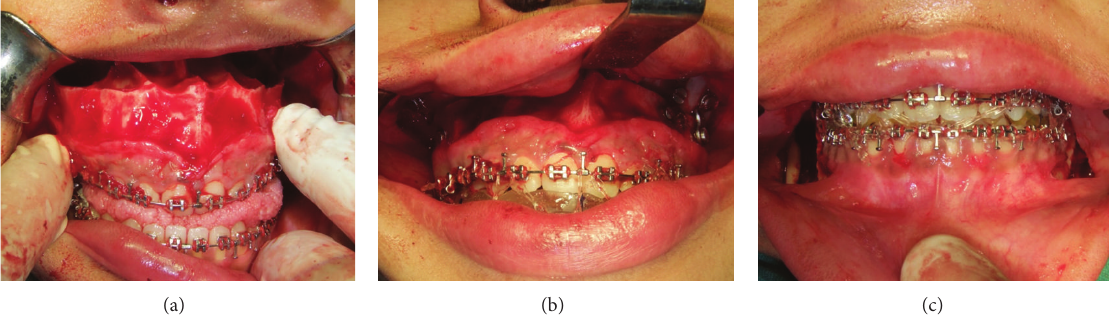
Figure15:(a)LeFortImaxillaryosteotomy,(b)rigidfixationwithboneplatesandintermediateocclusalsplint,and(c)BSSOwithmandibular setback and final occlusal